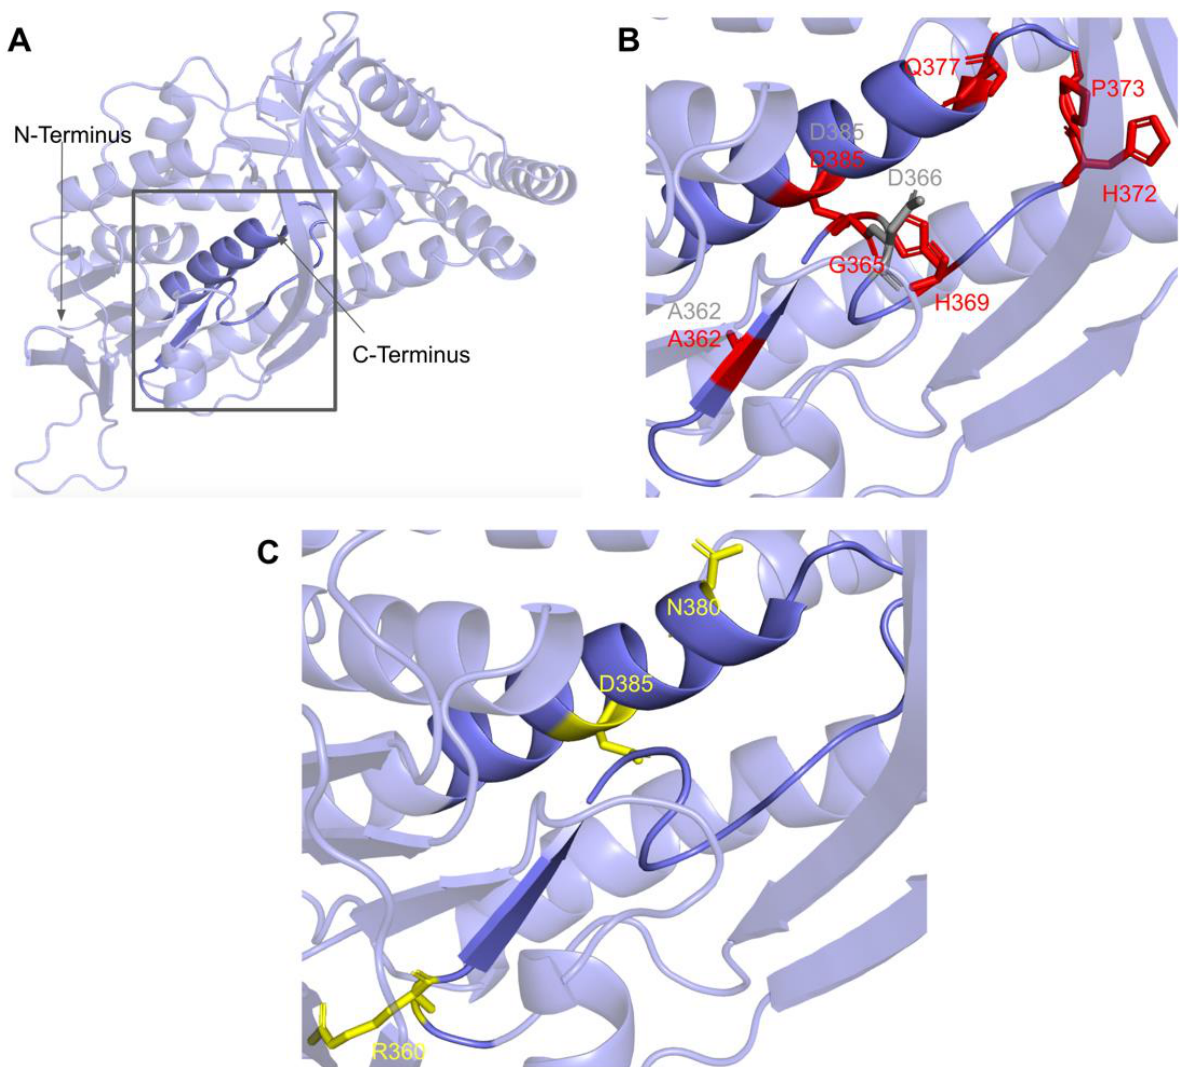
Figure 23. SNVs found in the COQ6 ribityl binding motif. ( A ) Ribityl binding motif is highlighted on the COQ6 model, from residues P359 to H392. Residues 1–35 have been truncated. ( B ) Locations of SNVs in conserved or functional regions are depicted. ( C ) Locations of ClinVar and literature variants are depicted. Residues are colored according to their corresponding SNVs in Figure 19.